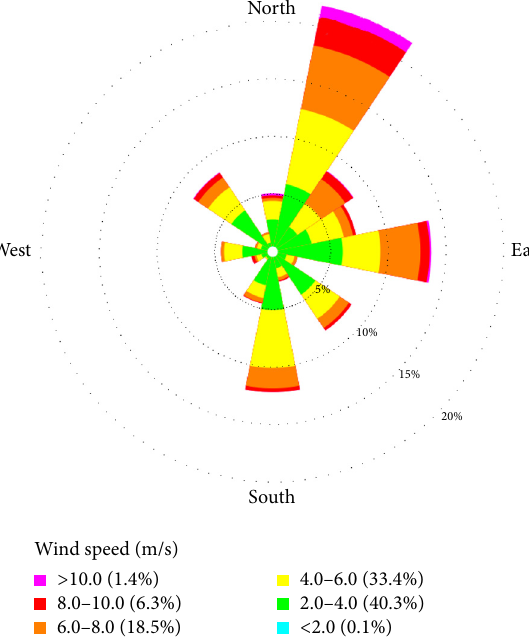
Figure 7: Polar diagram: wind direction for Ab´ech´e.